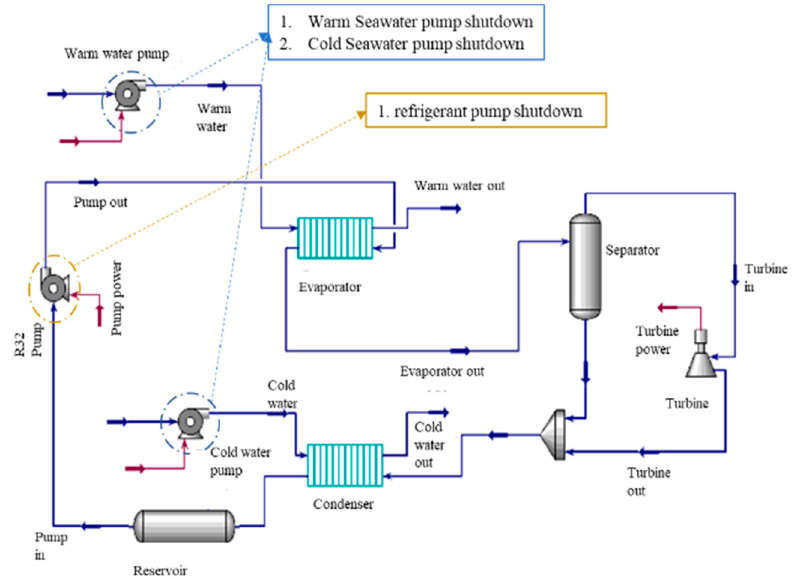
Figure 2. Closed-cycle